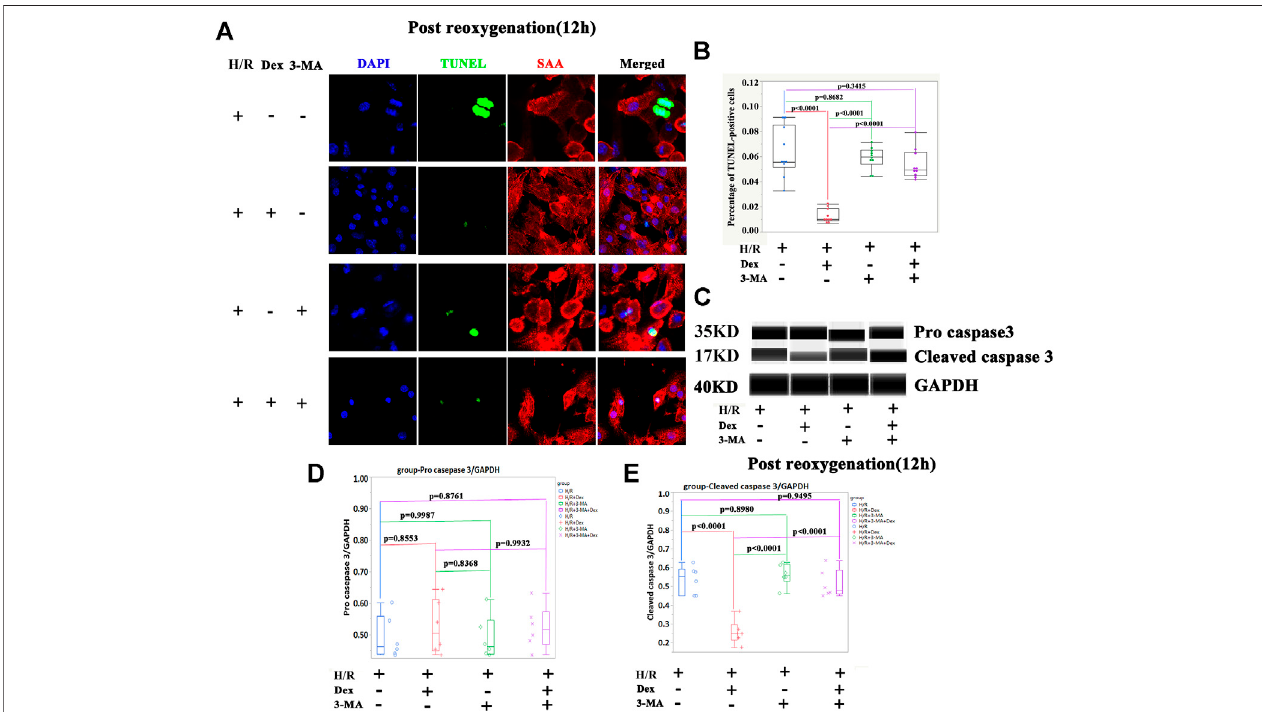
FIGURE 4 | The autophagy inhibitor (3-methyladenine, 3-MA) blocked the protection of Dex during I/R injury. (A) Representative TUNEL immuno fl uorescence imagesofiPSC-CMspretreatedwith3-methyladenine(3-MA).Blue(DAPI),green(TUNEL),red(sarcometric α -actin,SAA). (B) Quanti fi cationoftheTUNEL-positivecells. N (cid:2) 10 fi elds from three independent experiments. (C) Representative pro-cleaved caspase 3 Wes blot of iPSC-CM pretreated with Dex and 3-MA. (D) Quanti fi cation of the pro-caspase 3 relative expression. N (cid:2) 6 replicates. (E) Quanti fi cation of the cleaved caspase 3 relative expression. N (cid:2) 6 replicates.